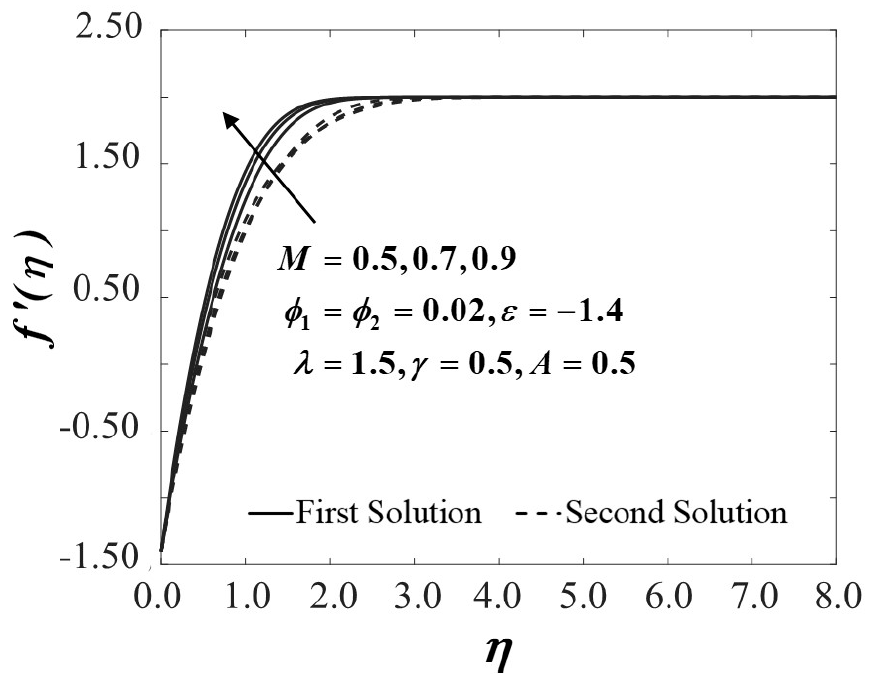
Figure 13. Velocity profiles of f (cid:48) ( η ) for di ff erent values of M .